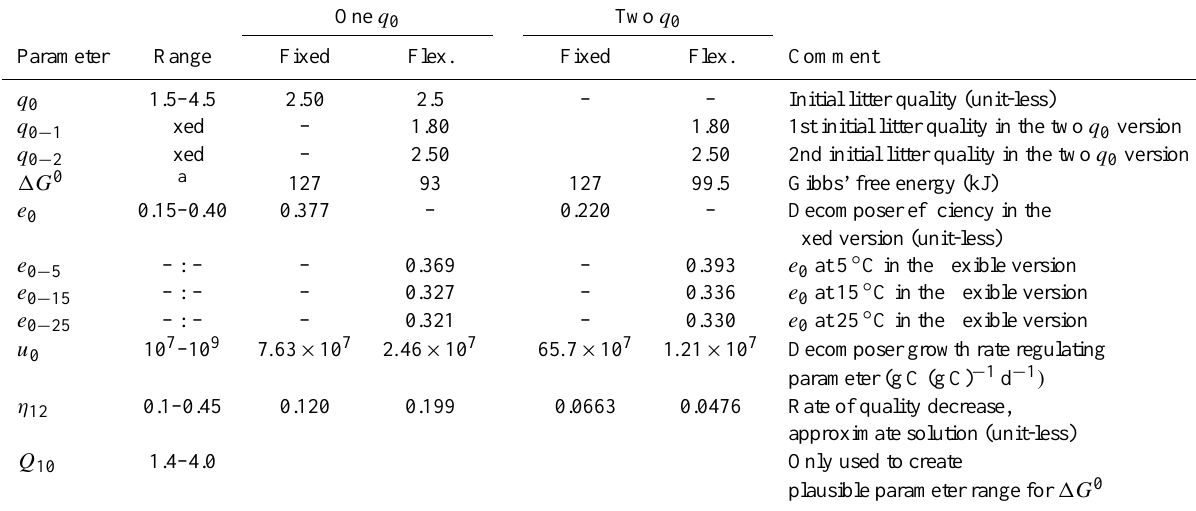
Table 1. List of parameters. Parameter values are those corresponding to the highest LM. Range is the range used in the calibration procedure. Sampling was done uniformly for all parameters but u 0 which was sampled from a log-distribution. With two initial qualities the q 0 ’s ( q 0 − 1 and q 0 − 2 ) were fixed from values obtained with one initial quality ( q 0 ) . Fixed and Flex. in the table heading refer to fixed or flexible e 0 . Initial parameter range was greater to find suitable parameter space.